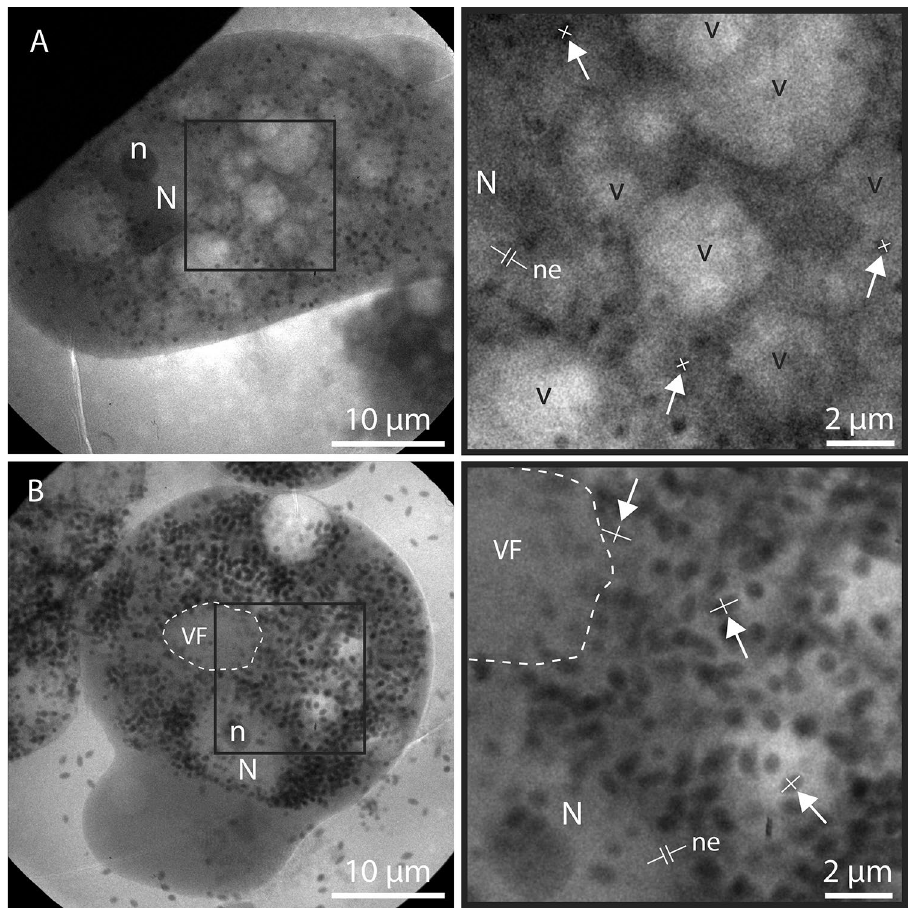
Figure 2. Laboratory full-field water-window cryo-microscopy of non-infected and infected amoeba. X-ray micrographs of a typical ( a ) non-infected amoeba (n = 14) and ( b ) infected amoeba imaged 54 hpi (n = 5). The images to the right show enlargements of the square insets. The appearance of numerous large (~ 1-µm length) ovoid virions in the infected cell clearly distinguishes it from the non-infected cell, which contains smaller (typically < 500 nm) and more circular objects, probably mitochondria or storage granules. A possible viral factory (VF) in the vicinity of the nucleus is indicated by the dashed white line. In order to clearly show the difference between the virions and the smaller X-ray absorbing objects, three examples in each image have been marked by arrows and a white cross indicating their length and width. Another striking difference is the typical vacuolated structure (v) of the non-infected cell, which is less prominent in the infected cell. Note that the nucleus (N) including the darker nucleolus (n) and the nuclear envelope (ne) appears to be intact in both cells. Scale bars are 10 µm in the whole images and 2 µm in the